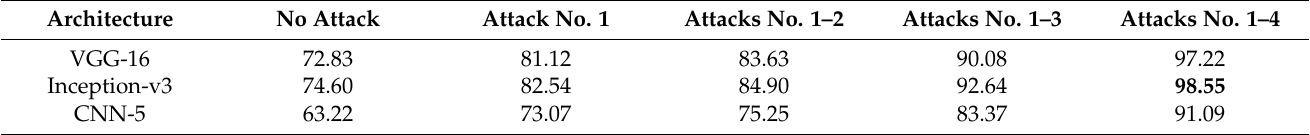
Table 5. Percentage of correct MNIST.DIGITS image recognitions with prevention of visual attacks.